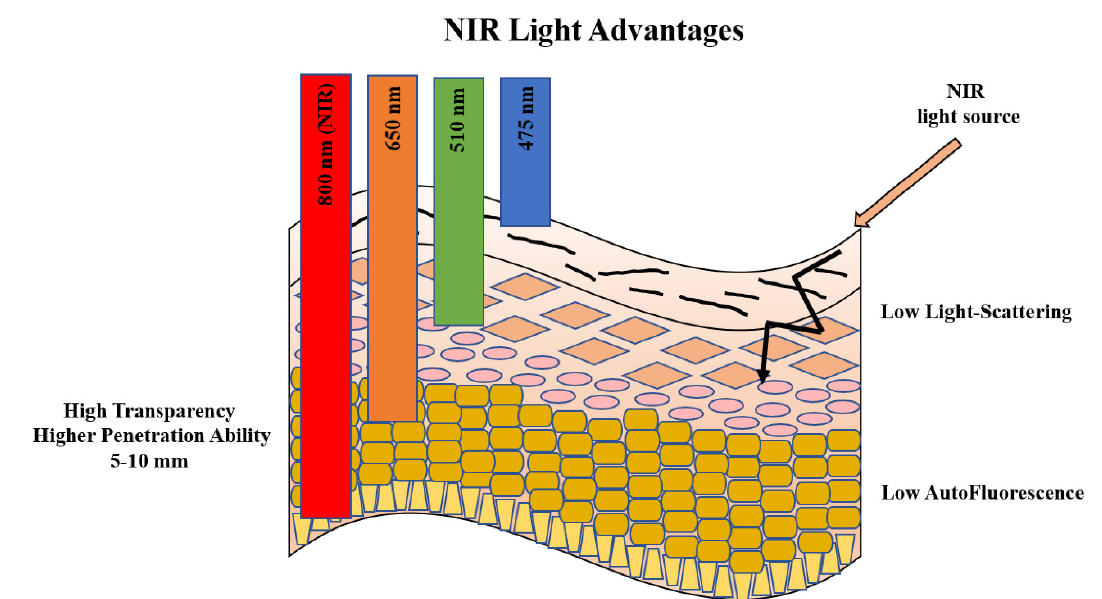
Figure 4. Advantages of the use of near-infrared light. The fluorescence imaging technique with near-infrared is widely used due to its superior qualities since their range of absorbance and fluorescence corresponds to the region of highest transparency of biological tissues. In fact, at these wavelengths, the light penetrates deeper through animal tissue (because the combined effects of tissue absorbance and light scattering are at a minimum), and autofluorescence of biological tissues is less pronounced compared to the visible range.